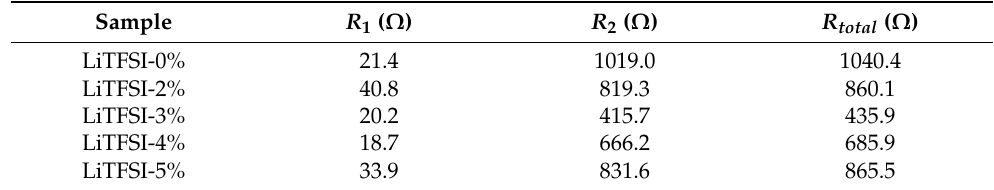
Table 1. Resistances and ionic conductivity of the X% LiTFSI (X = 0, 2, 3, 4, and 5) +LiFePO 4 cathode//LATP/PVDF-HFP electrolyte membrane// Li cells.